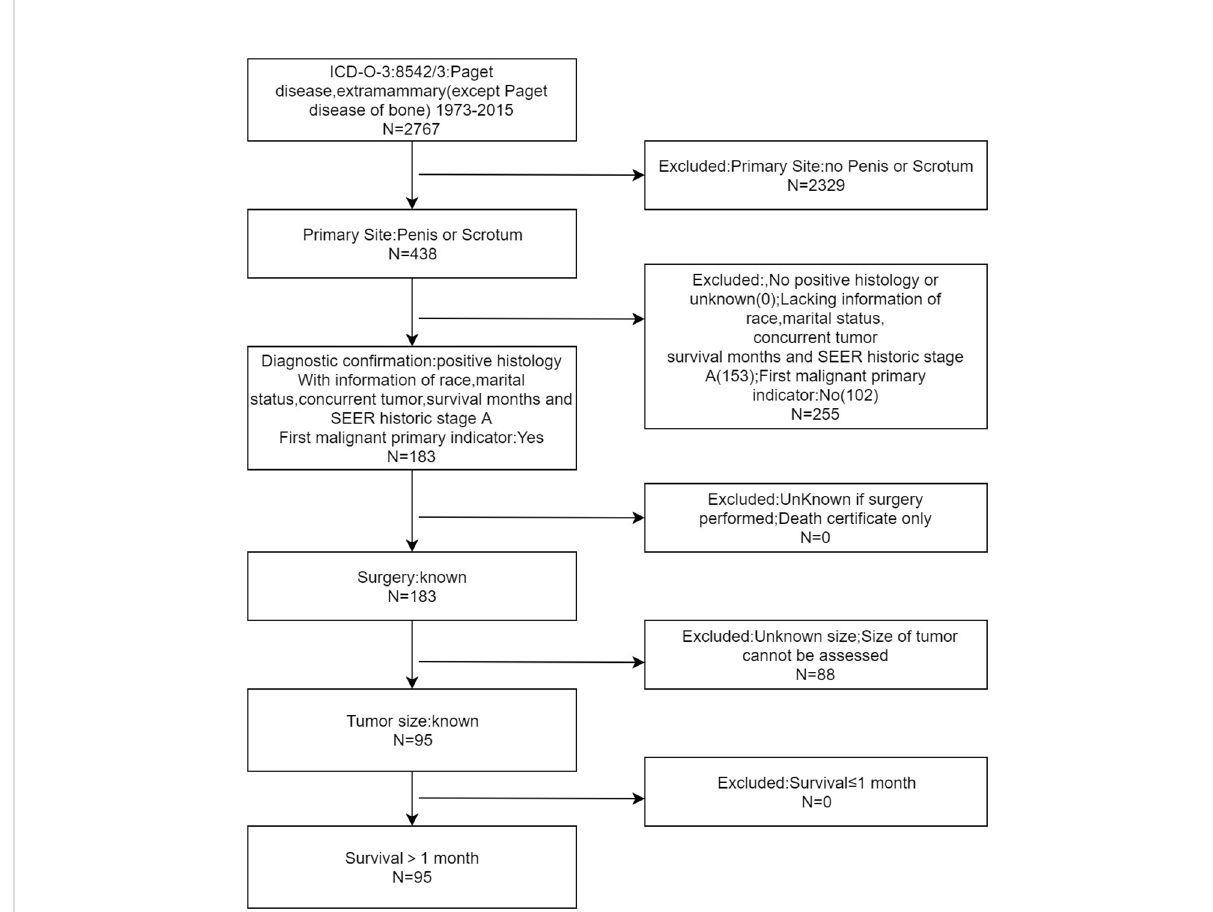
FIGURE 1 Flow diagram of patients with penoscrotal EMPD enrollment from SEER